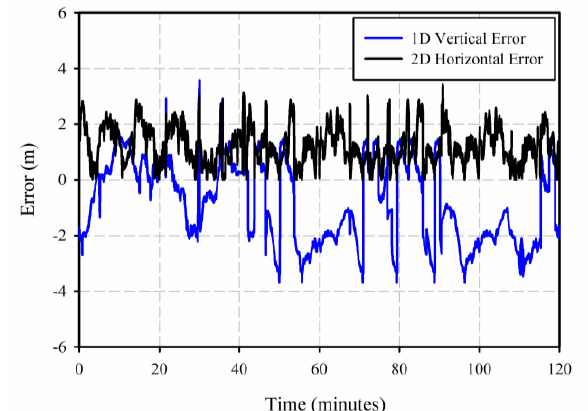
Figure 4. 2D horizontal Errors and 1D Vertical Errors of Low- cost Single-frequency Receiver